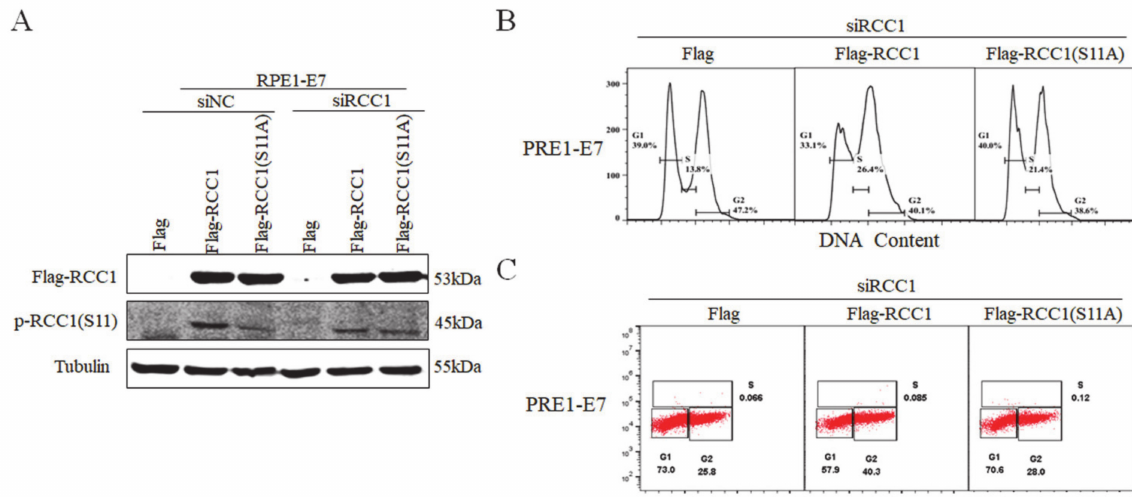
Figure 4. Phosphorylation of RCC1 S11 promoted G1/S cell cycle progression. ( A ) RCC1 were first knocked down with siRNA for 12 h in RPE1-E7 cells, then transfected with Flag, Flag-RCC1 or Flag-RCC1(S11A) plasmid for 12 h. The expression of p-RCC1(S11) and Flag-RCC1 proteins were measured by Western blot. ( B ) Flow cytometric analysis of cells mentioned in ( A ) with bleomycin treatment for 36 h. ( C ) BrdU incorporation analysis of cells mentioned in ( A ) with bleomycin treatment for 36 h. Data shown are representative of 3 biological